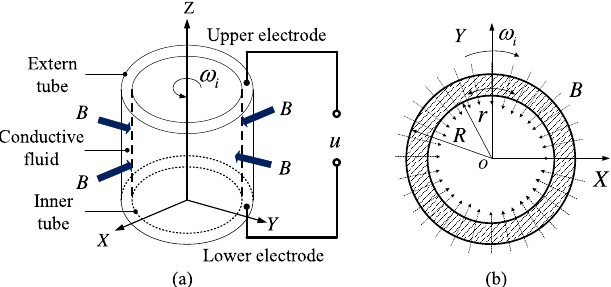
ð 4 Þ Fig. 1. MHD angular vibration sensor ’ s equivalent model.